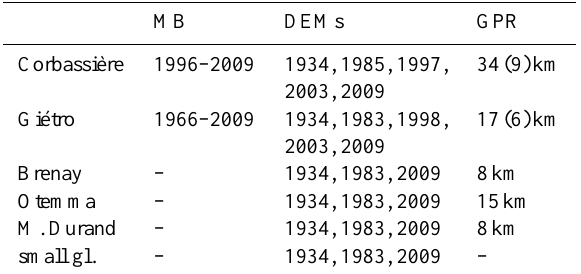
Table 2. Availability of different data sets used for this study: mass balance measurements (MB), DEMs, and the length of GPR pro- files. Numbers in brackets indicate the fraction of ground-based GPR profiles from the total length of helicopter- and ground-based GPR profiles for each glacier. MB GPR